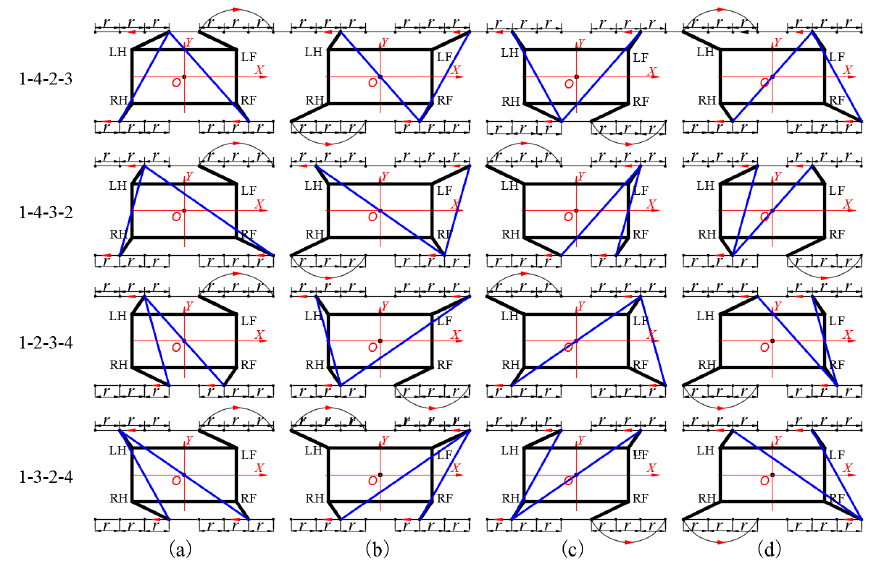
Figure 9. Gait diagrams in different sequences. ( a ) the moving of LH and RF, ( b ) the moving of LH, and RH, ( c ) the moving of LF, and RF, ( d ) the moving of LF and RH. The triangle formed by the two blue straight lines in each gait diagram of Figure 9a–d and the straight line between the two feet on the same side represents the center of gravity stable area. When comparing the four moving modes, the 1–4–2–3 moving mode is the most stable because it has a sufficient stability margin. The O point of the center of gravity of the other three movement modes all have moments outside the